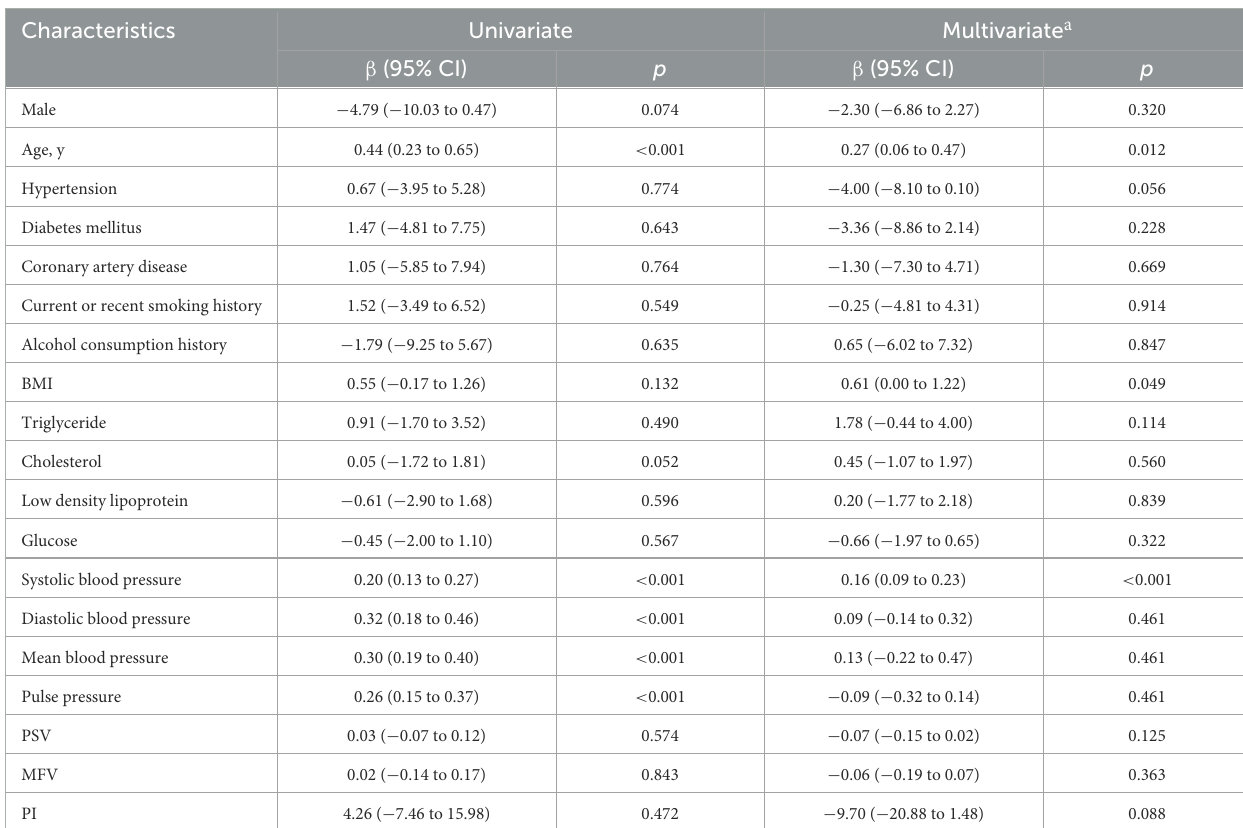
TABLE 4 CrCP association with demographics and baseline characteristics.